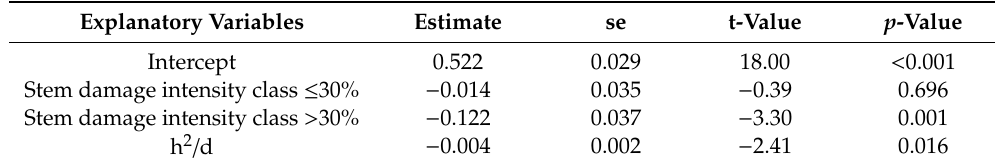
Table 4. Parameter estimates of the fixed e ff ects of the fitted snapping height model for Norway spruces. SE—standard error.